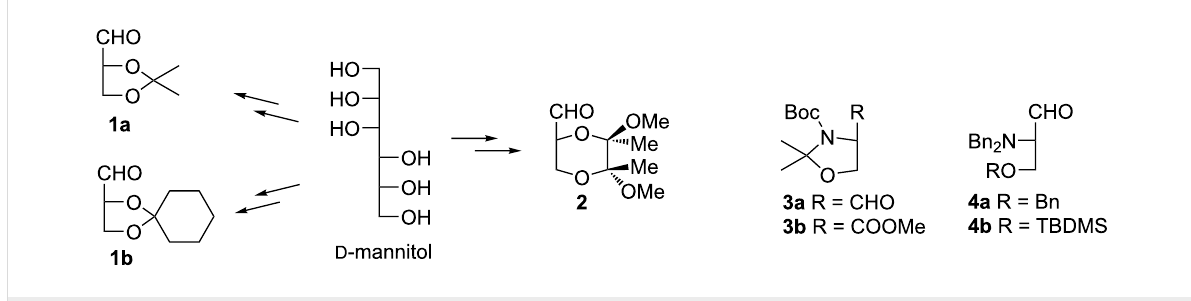
Figure 1: Examples of three-carbon chirons.